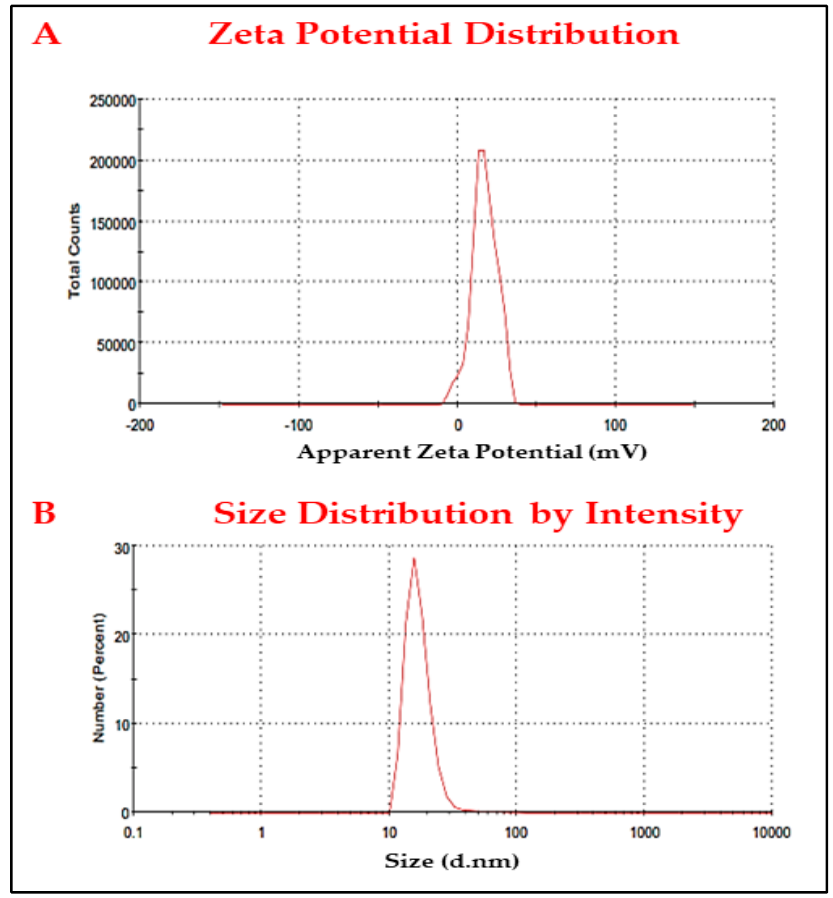
Figure 6. ( A ) ζ− potential analysis and ( B ) DLS of the synthesized AgNPs using ELLE. Figure 6. ( A ) ζ − potential analysis and ( B ) DLS of the synthesized AgNPs using ELLE.